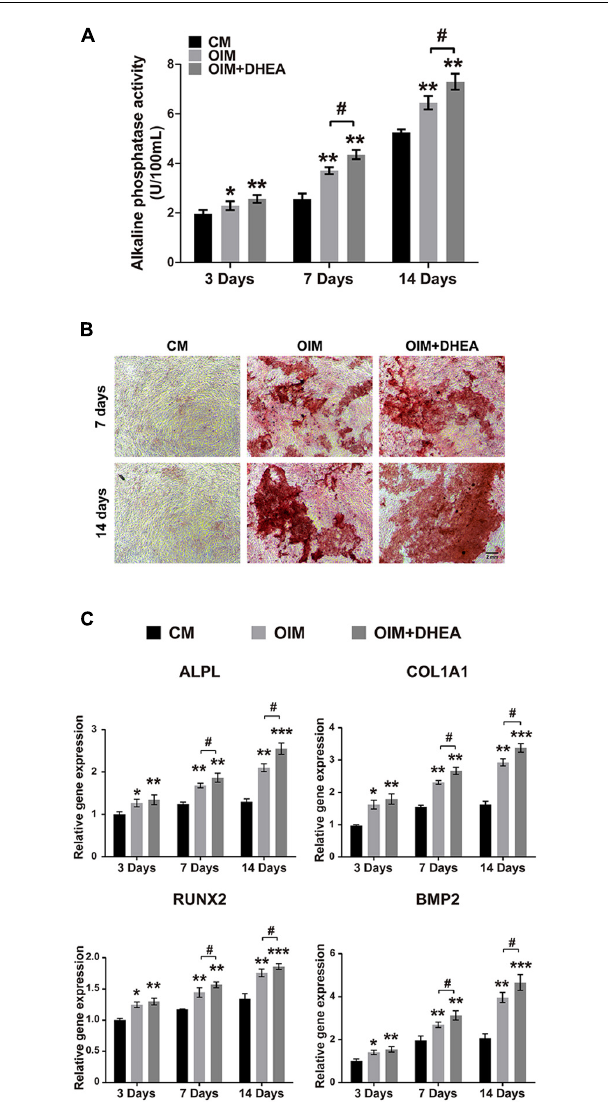
FIGURE 2 | DHEA promotes the osteogenic differentiation of BMSCs in vitro . (A) ALP activity was analyzed after 3, 7, and 14 days of hBMSCs culturing with CM, OIM, and OIM supplemented with 10 nM of DHEA. Error bars: mean ± SD. N = 3, *, # indicates p < 0.05, **indicates p < 0.01. (B) Alizarin red staining of osteogenic hBMSCs treated with or without 10 nM of DHEA for 7 and 14 days (Scale bar = 2 mm). (C) The mRNA expression of Alpl, Col1a1, Runx2, and Bmp2 was detected in the CM, OIM, and OIM+DHEA groups at the indicated time by qRT-PCR analysis. Error bars: mean ± SD. N = 3, *, # indicates p < 0.05, **indicates p < 0.01, ***indicates p <